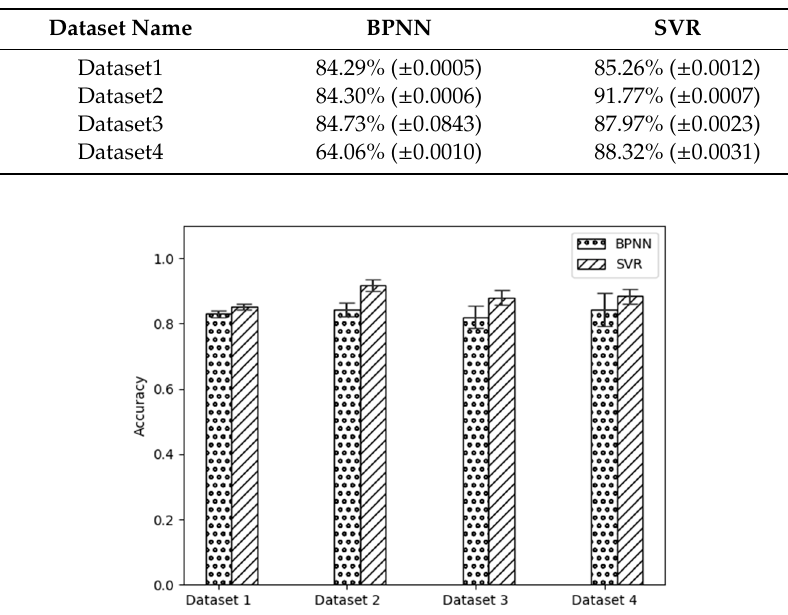
Table 2. Wind turbine fault detection rates with BPNN and SVR.